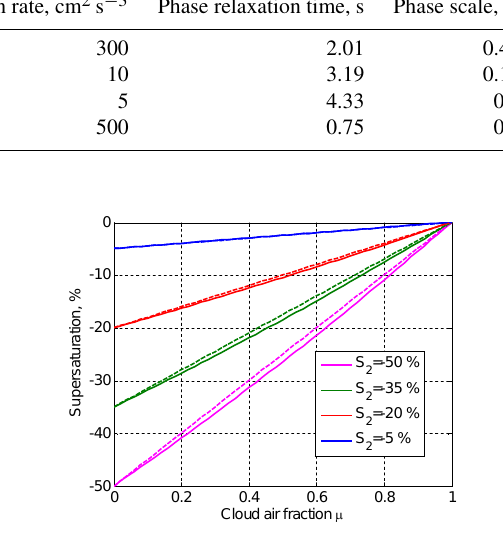
Table 1. Linear scales of volumes experiencing homogeneous mixing at conditions typical of different cloud types. Cloud type N , cm − 3